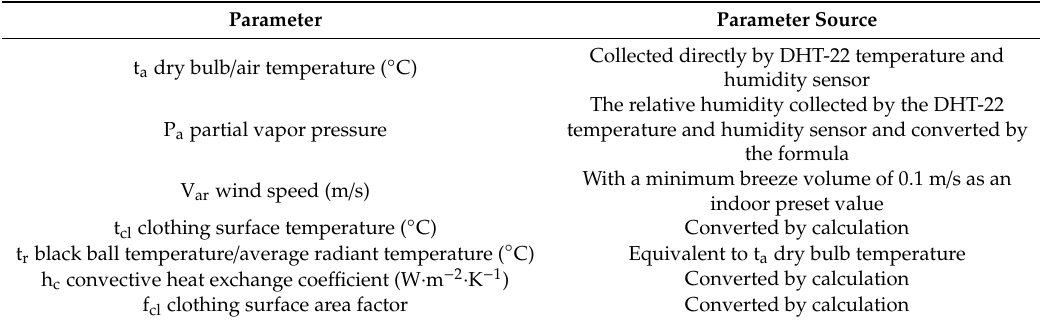
Table 3. Source of the parameters of